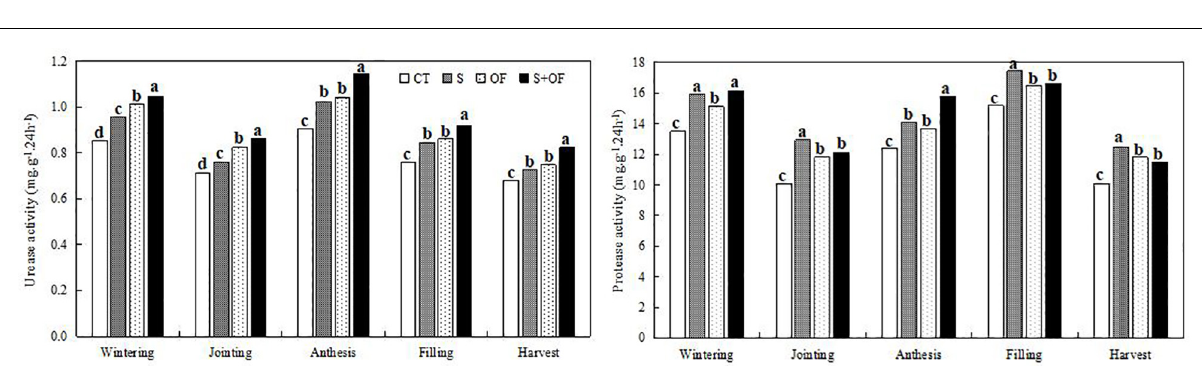
FIGURE 4 | Effects of subsoiling, organic fertilizer and subsoiling combined with organic fertilizer on sucrase activity and cellulase activity of soil at different growth stages of winter wheat in 2019. CT, conventional tillage: S, subsoiling; OF, organic fertilizer; S+OF, organic fertilizer combined with subsoiling. Different lowercase letters in the same growth stage indicate significant differences among treatments by LSD test ( P < 0.05).